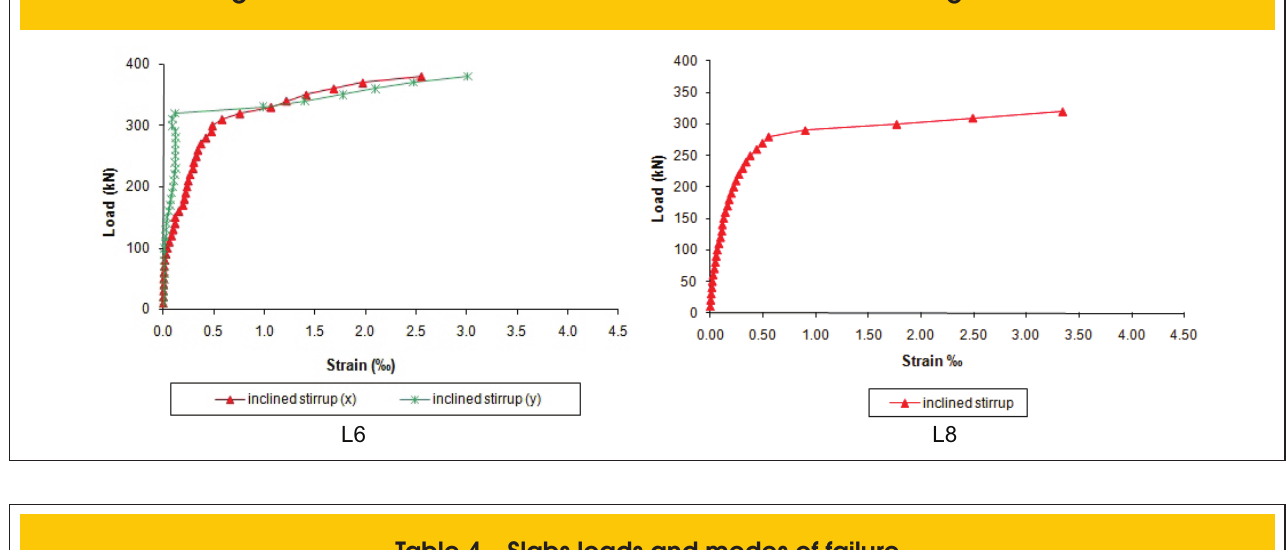
Figure 16 – Slabs L6 and L8 shear reinforcement in the solid region strains